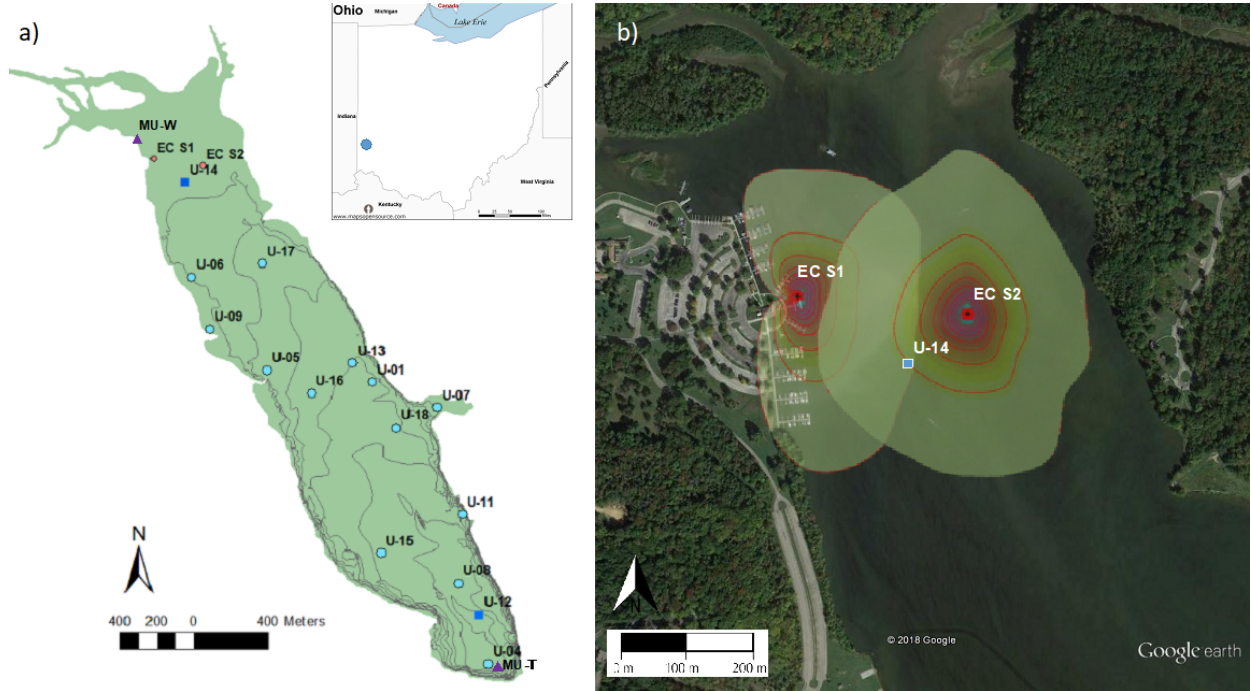
Figure 1. Map of Acton Lake (a) , showing the location of multiple monitoring methods: eddy covariance flux tower sites (red circles), active funnel traps and biweekly chamber measurements (dark blue squares), spatially extensive survey sites (light blue circles), and the weather station and thermistors operated by Miami University (purple triangles). The lake contour lines represent ∼ 1m depth increments. Inset image shows the location of Acton Lake in southwest Ohio. The Google Earth image (b) shows the 80% cumulative footprint probability distribution at each eddy covariance flux tower site at 10%